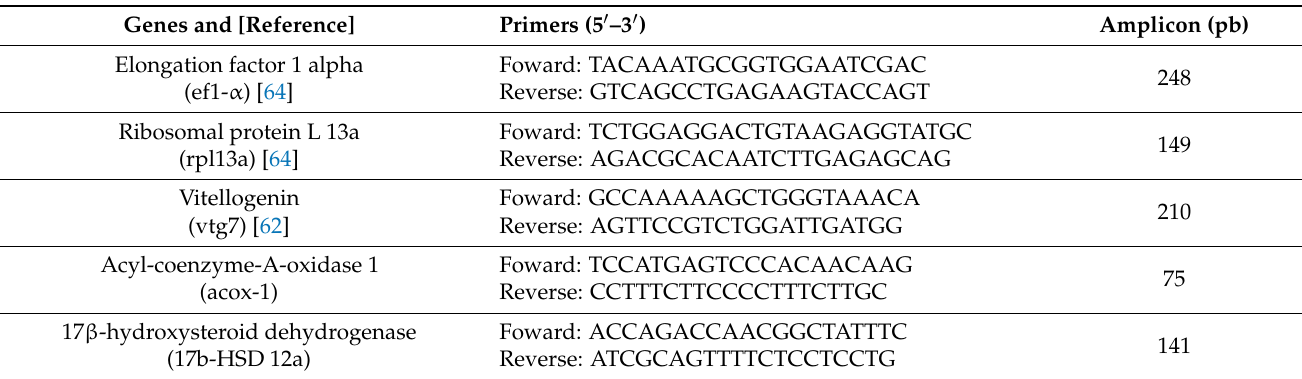
Table 2. Primer sequences of genes tested in this